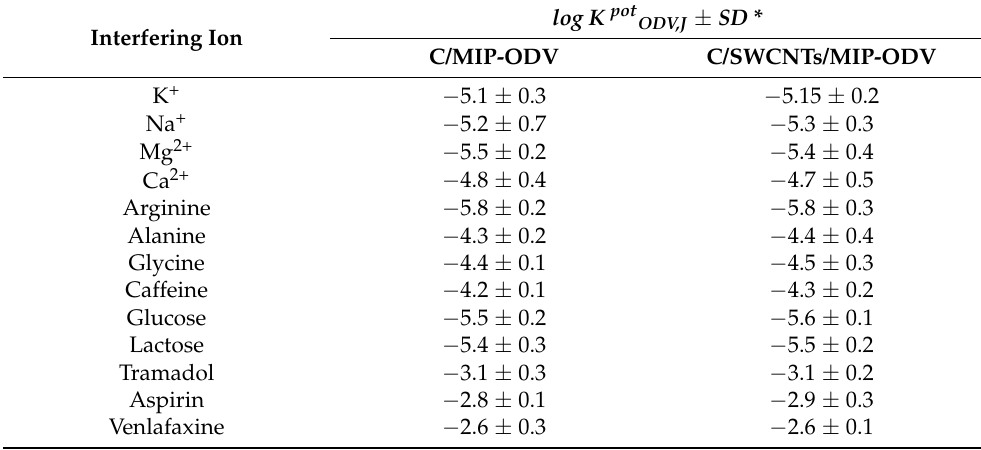
Table 3. Selectivity coefficients ( log K pot ODV,J ) of the presented ODV- membrane based